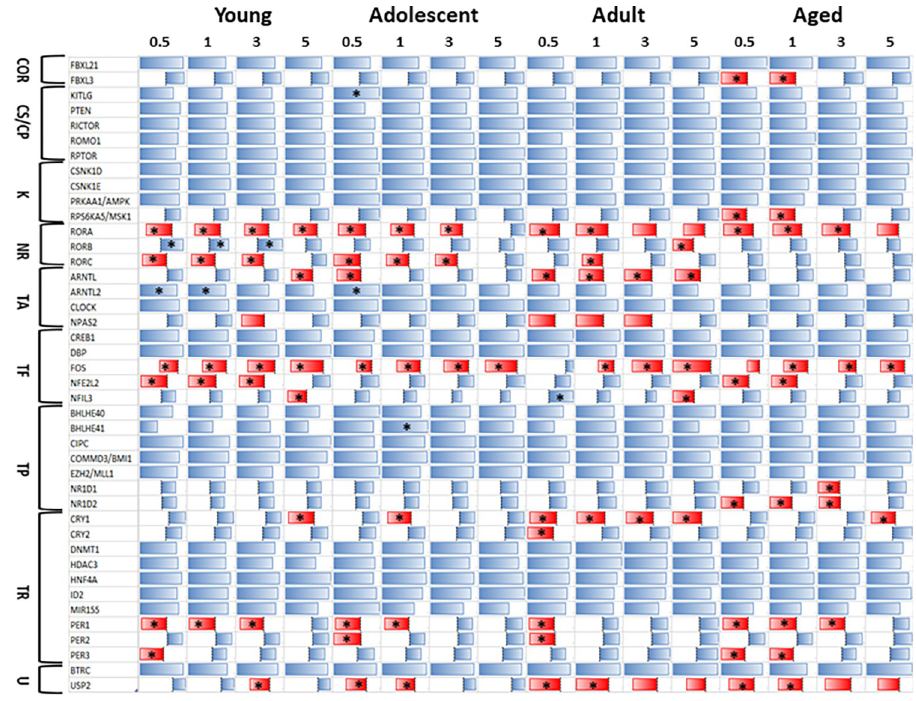
Fig 2. Circadian rhythm pathway gene expression profiles in young, adolescent, adult, and aged gingival tissues samples during ligature induced disease. This analysis used a z-score normalization within a gene across all time points compared to adult baseline (healthy) values. Functional designation of the genes are as in Fig 1. Red bars denote decreased levels and asterisk ( � ) denotes significantly different from healthy adult levels at p < 0.05.